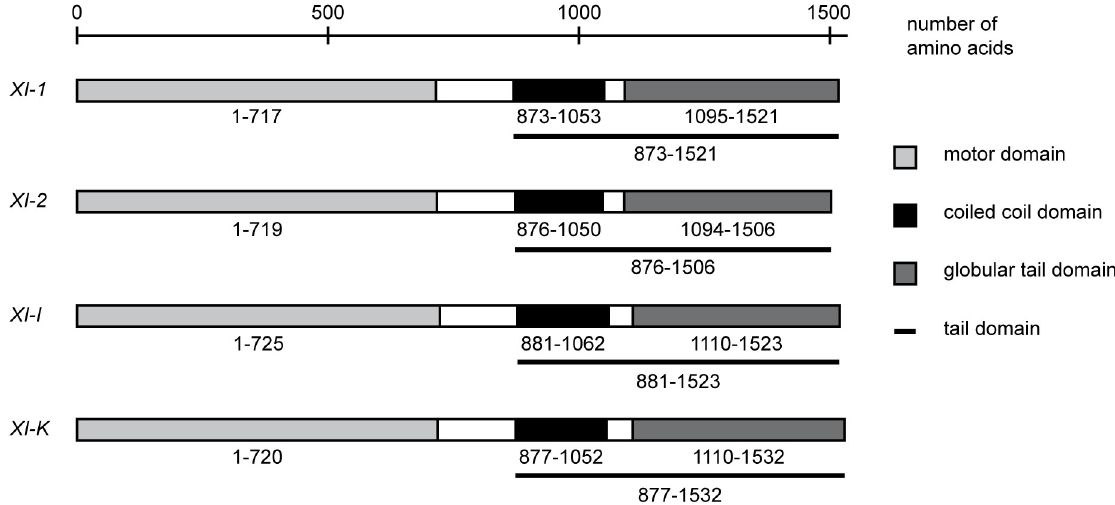
Fig 2. Domain structure of class XI myosins. All myosin fragments used in this work were designed according to the domain structure. Sequences were taken from TAIR [45] and NCBI (National Centre for Biotechnology Information, www.ncbi.nlm.nih.gov). Conserved domains were determined using CD-Search [46] and/or PROSITE